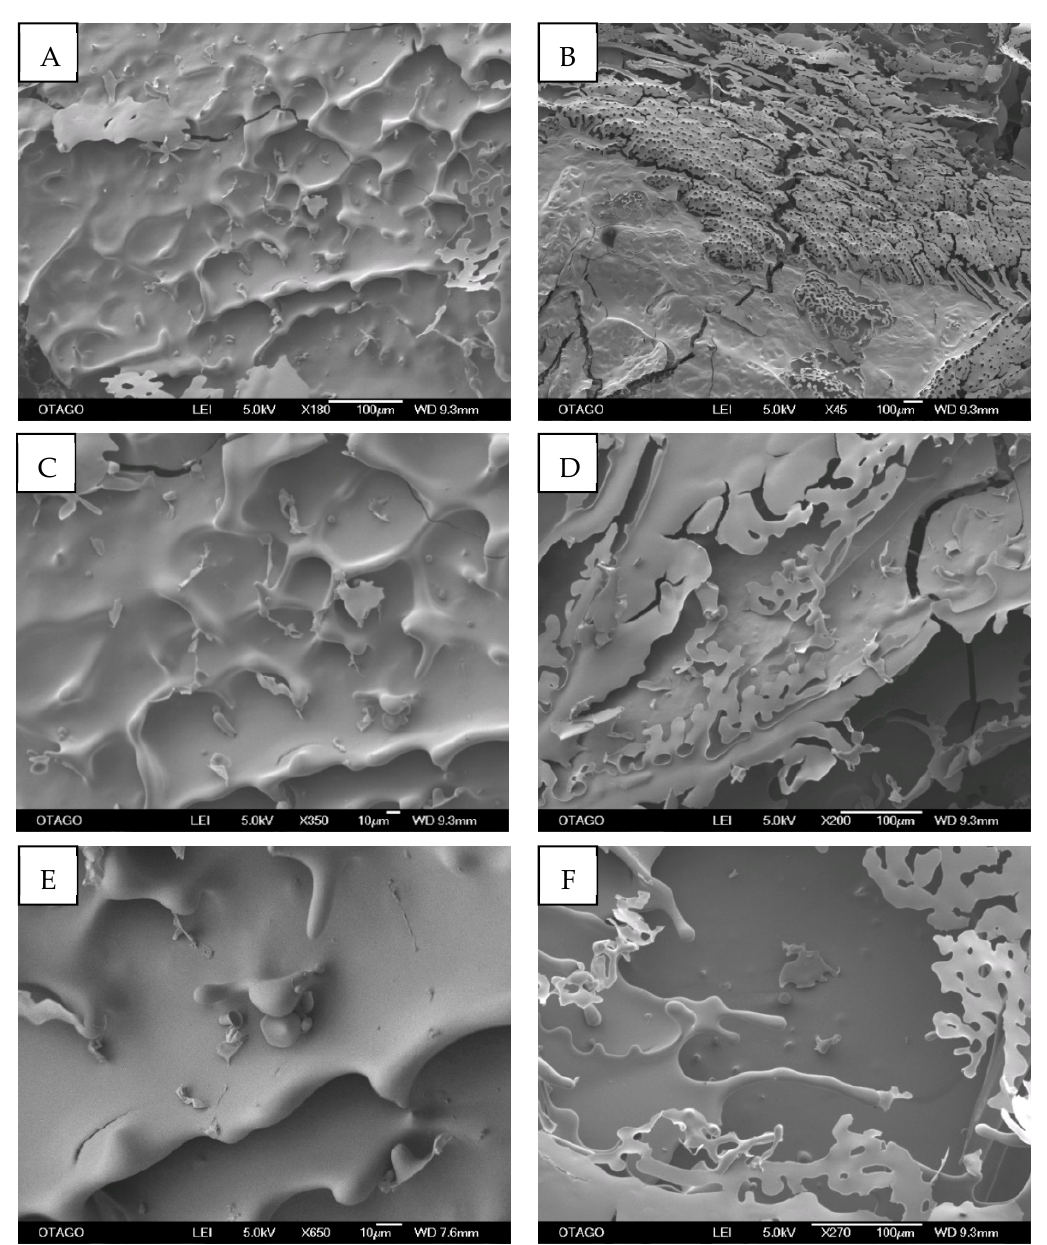
Figure 3. Representative scanning electron microscope (SEM) micrographs of surface of intact Ly-PRF, which showed irregular-surface topographical appearance. SEM magnifications: (( A ) × 45, ( B ) × 180, ( C ) × 200, ( D ) × 270, ( E ) × 350, and ( F ) × 650). (Bar = 100 µm).